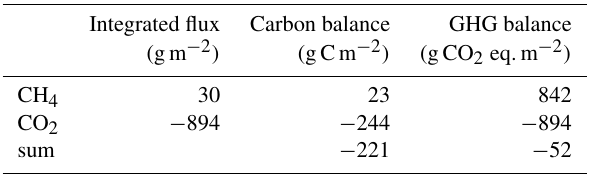
Table 2. Annual integrated flux, carbon balance and greenhouse gas (GHG) balance for CH 4 , CO 2 and the sum of both gases for carbon and GHG balance.